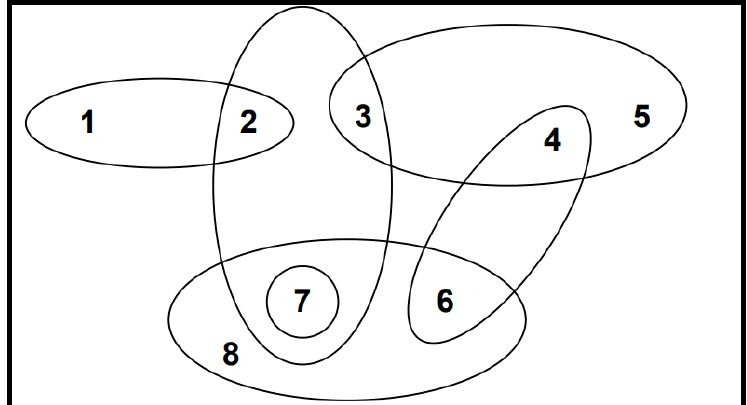
Figure 7. Hypergraph